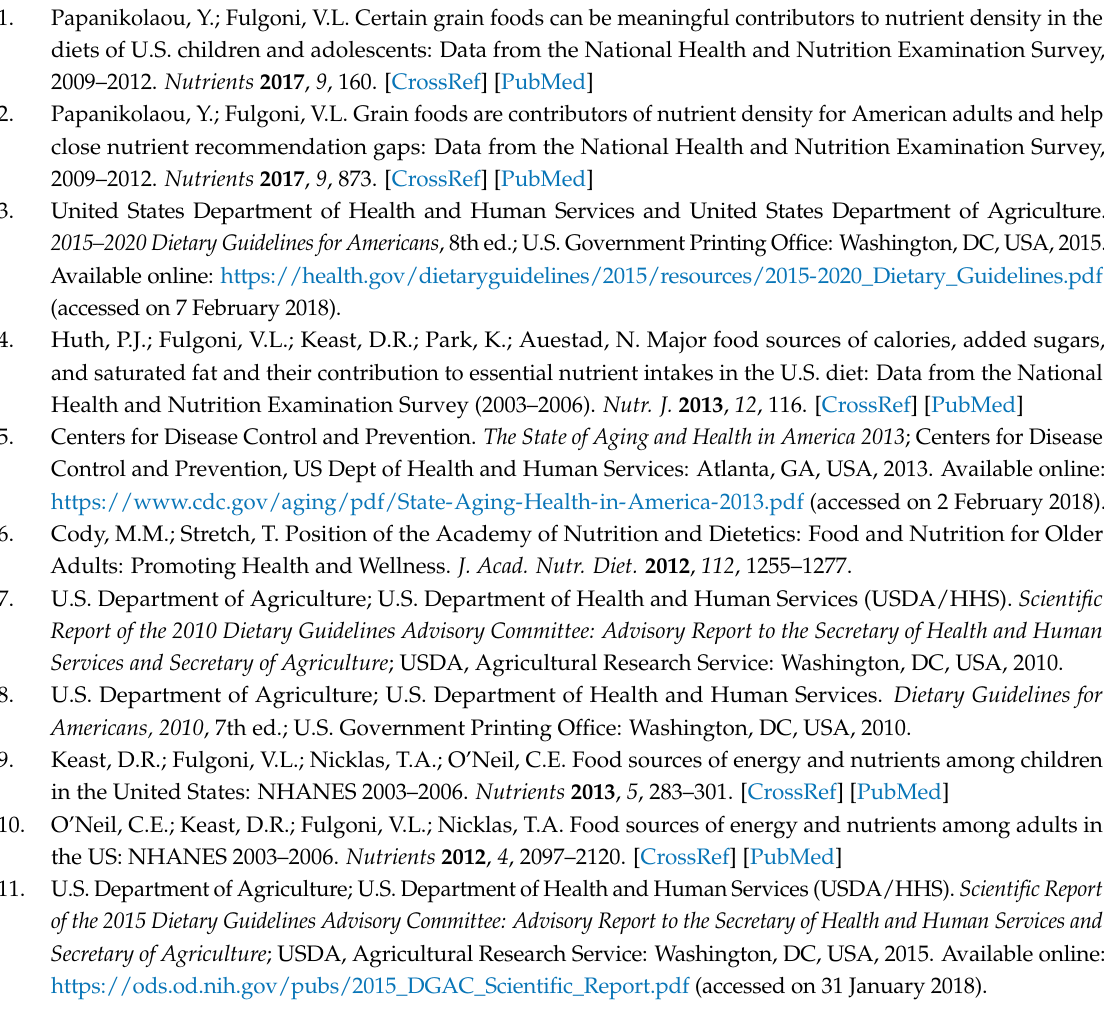
Table S18: Food sources of vitamin B6 contribution in the total U.S. diet, adults ≥ 51 years old ( n = 4522; gender combined; daily intake data; NHANES 2011–2014; subcategory groups contributing <1.0% not reported; data are Day 1 intakes), Table S19: Food sources of vitamin B12 contribution in the total U.S. diet, adults ≥ 51 years old ( n = 4522; gender combined; daily intake data; NHANES 2011–2014; subcategory groups contributing <1.0% not reported; data are Day 1